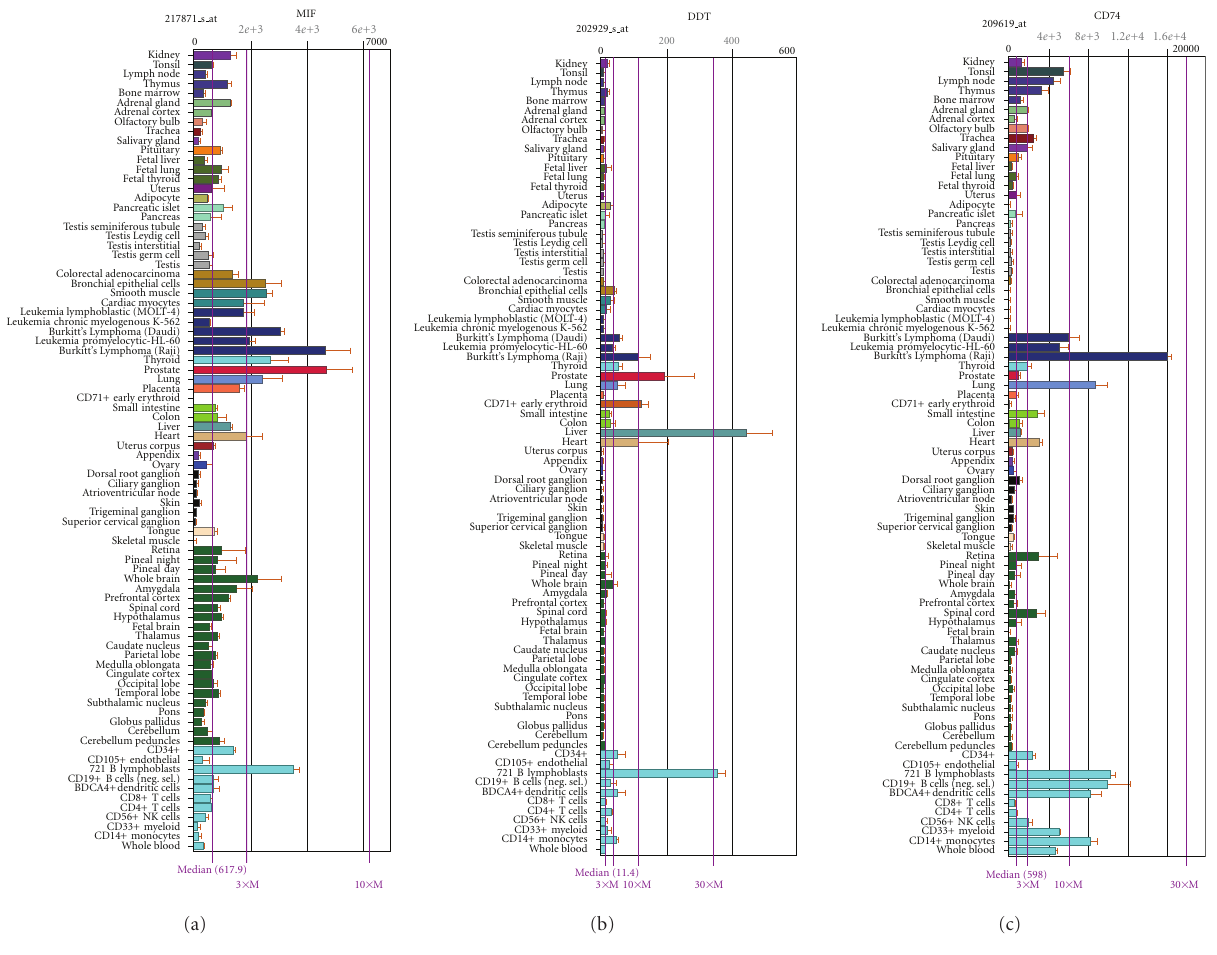
Figure 1: MIF, DDT, and CD74 distribution in human tissues. Comparative analysis of MIF, DDT (MIF-2), and its receptor CD74 expression in various human tissues. For human mRNA expression analysis, the BioGPS database (http://biogps.gnf.org profile graph) with the A ff ymetrix chip Human U133A was acquired. Note in particular the di ff erent expression values of MIF and DDT in brain tissue. For details on the A ff ymetrix chip analysis, see [37,